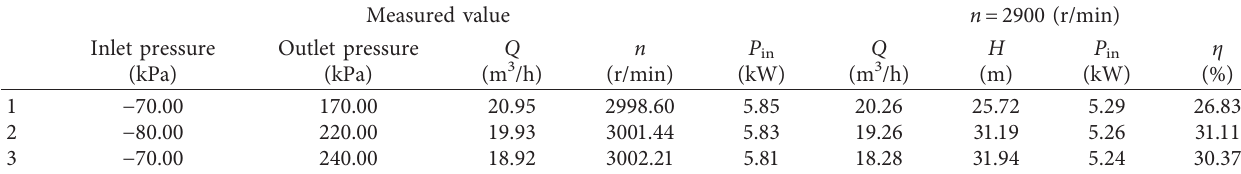
Table 4: Performance experiment of single arc